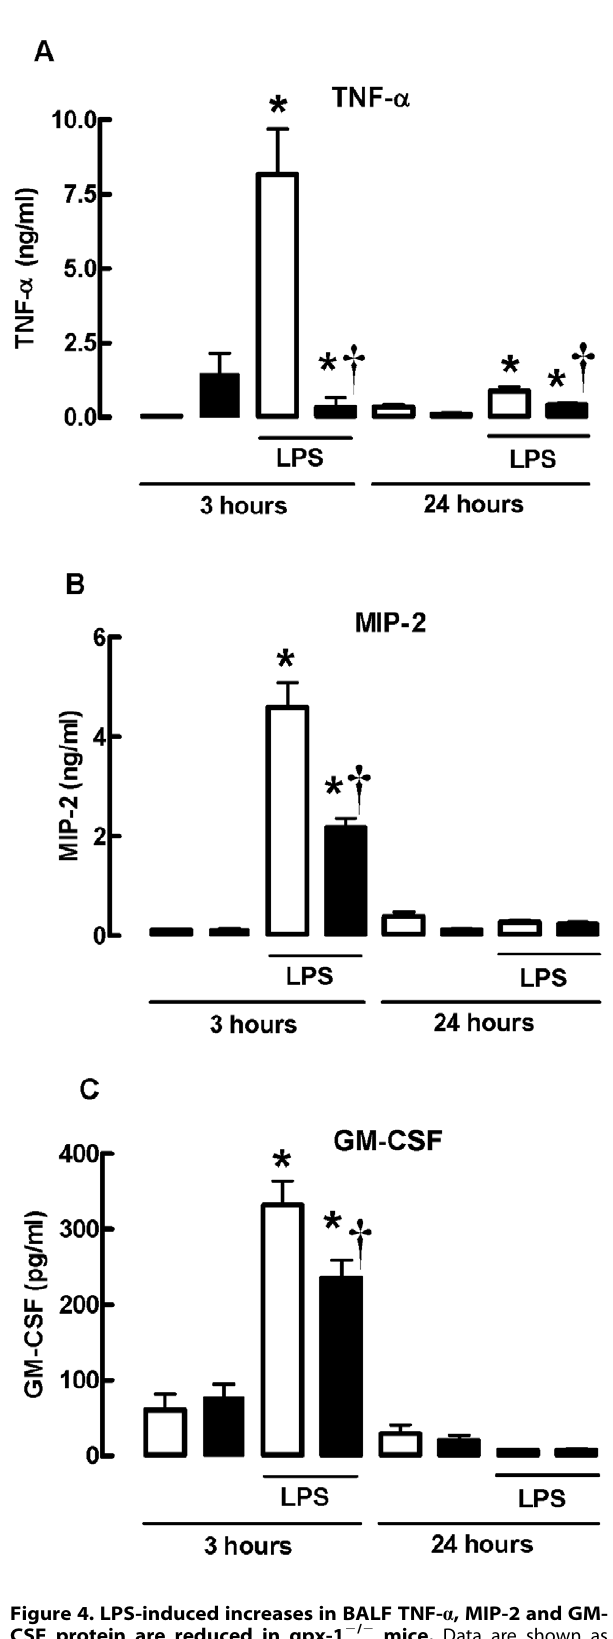
Figure 4. LPS-induced increases in BALF TNF- a , MIP-2 and GM- CSF protein are reduced in gpx-1 2 / 2 mice. Data are shown as mean 6 SEM for 6 mice per treatment group. Clear bars represent PBS- treated mice and black bars represent LPS-treated mice. * P , 0.001 vs respective PBS-treated mice (ANOVA and Bonferroni’s post hoc test),